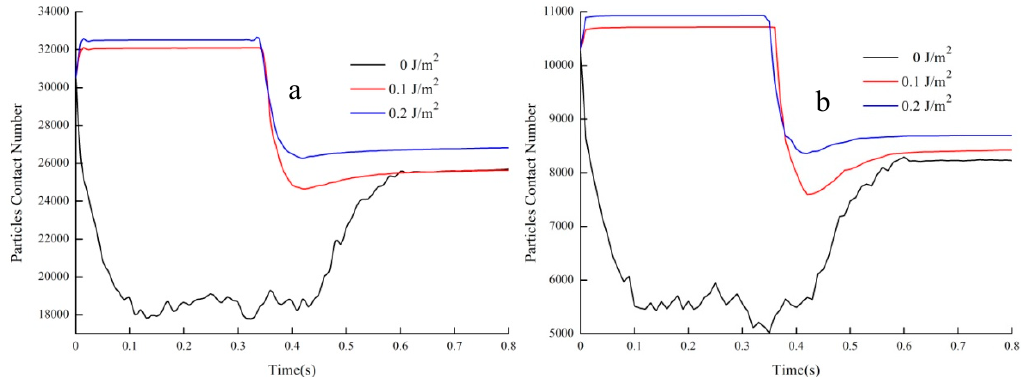
Figure 10. The total particles contact number of wet soil granular flow, the ( a ) and ( b ) diagrams represent results of soil-grain diameters of 0.7 mm and 1 mm respectively.